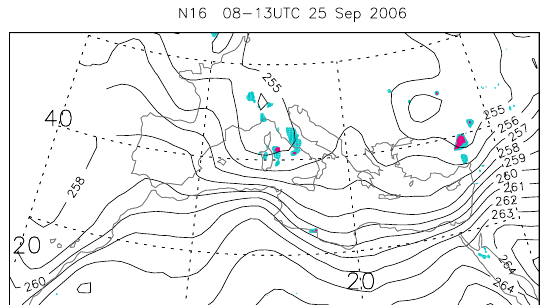
Fig. 5. AMSU-A channel 5 (in K), B3m5 (larger or equal to − 8K, blue shaded), and DCT (red shaded) for ascending (08:00– 13:00UTC) NOAA-16 passes, 25 September 2006. Isolines are dis- played every